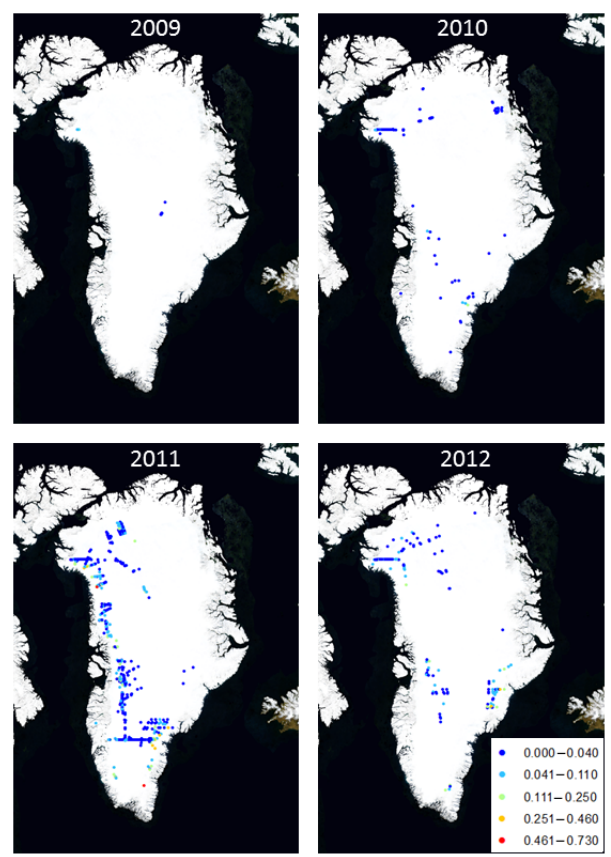
Figure 8. Maps of annual-crossover error (mw.e.a − 1 ) from the radar-derived accumulation for 2009 through 2012.